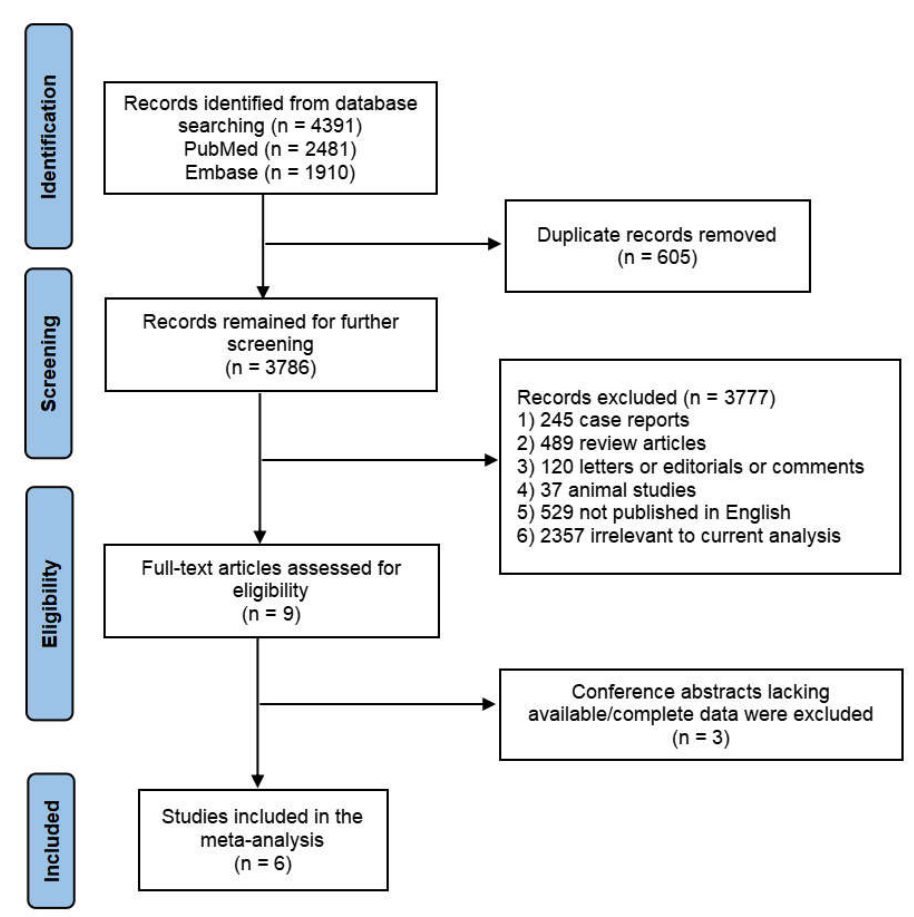
Figure 1. Flowchart of the study selection.